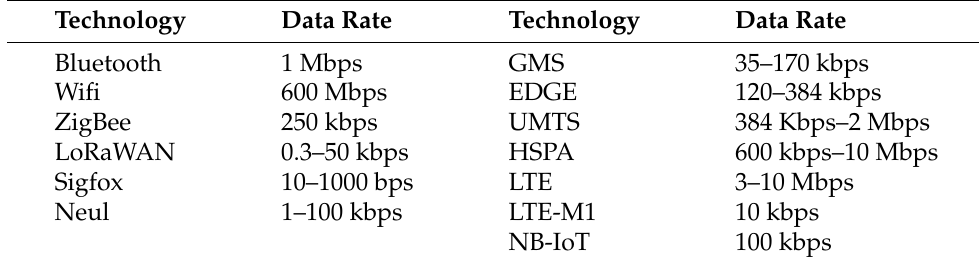
Table 2. More diffused radio networks used for IoT